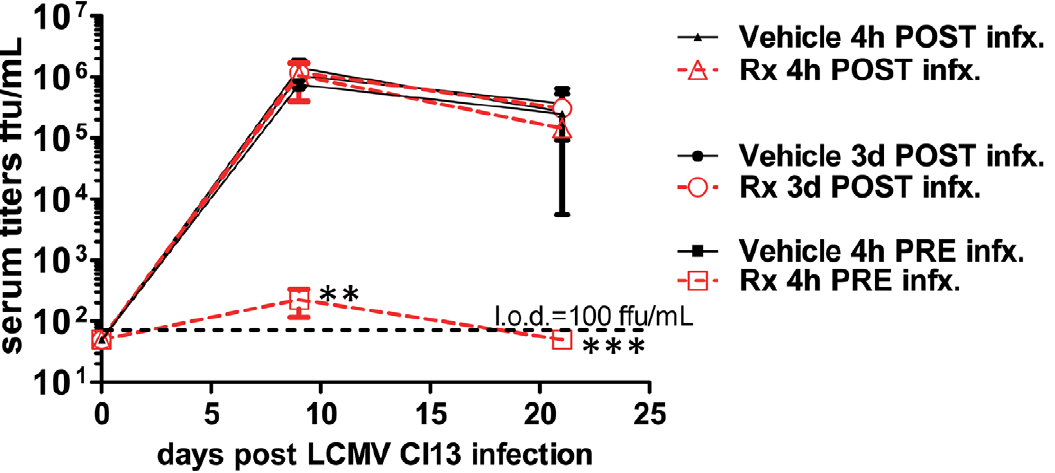
Figure 5. Prophylactic treatment with CpG-DOTAP prevents persistent viral infection. WT mice were treated with vehicle or i.v. 2 m g CpG- ODN in DOTAP (‘‘Rx’’) either 4 h prior, 4 h post or 3 days post infection with LCMV Cl13. Serum was collected at the indicated times post infection and titered for infectious virus. CpG-DOTAP: CpG-A plus DOTAP (Roche); l.o.d., limit of detection. Mean and standard error of the mean are shown for 5 mice per group of infected mice. 1 of 2 similar experiments is shown. Unless marked, p . 0.05 between treatment groups and not statistically significantly different.